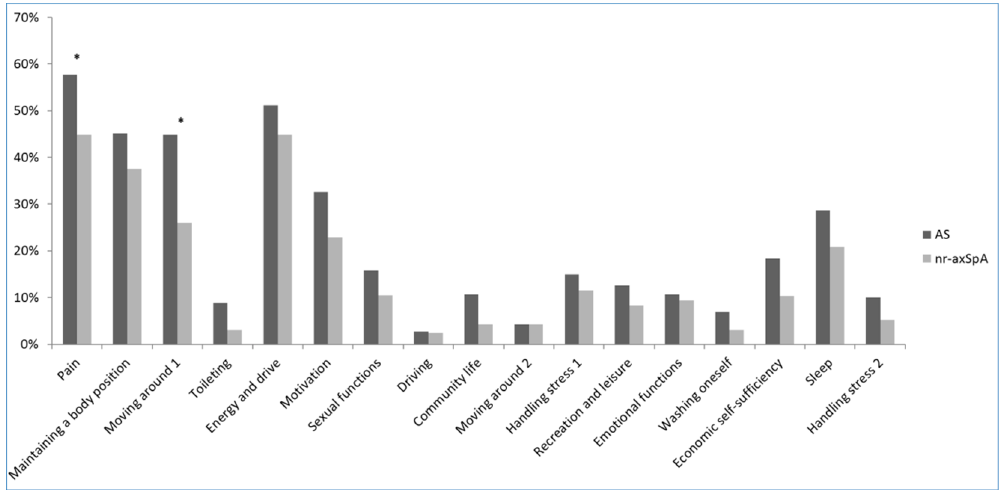
Figure 1. The frequency of ASAS HI items checked as “I agree” in the AS and nr-axSpA groups. * p < 0.05.